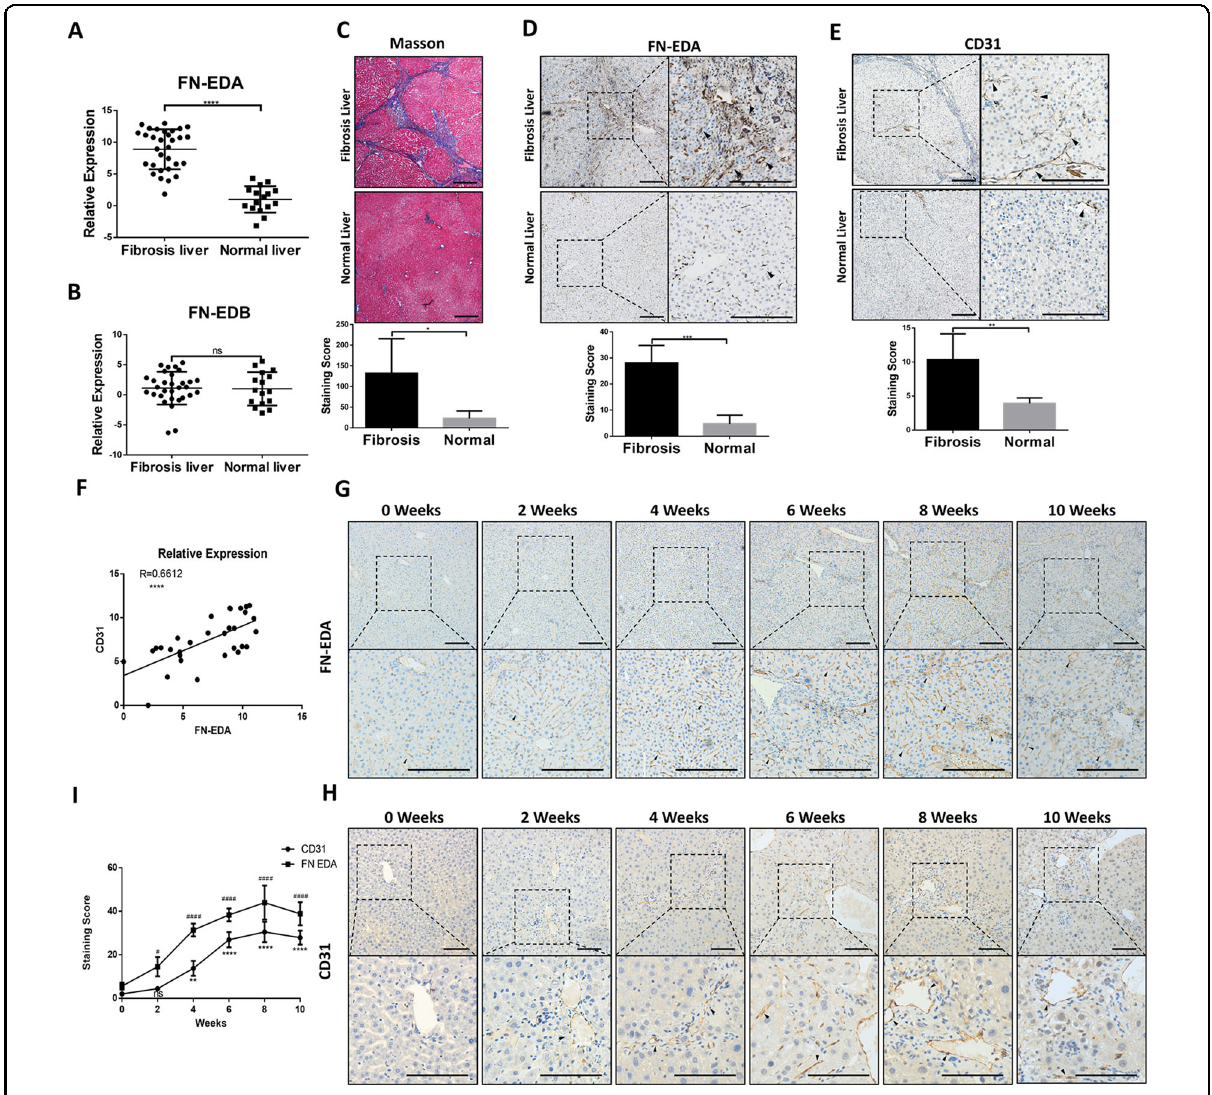
Fig. 1 Expression of FN-EDA is associated with CD31 in hepatic fi brosis. A , B qRT-PCR analysis of FN-EDA and FN-EDB mRNA levels between liver tissue of CHD patients ( n = 30) and healthy control ( n = 15). (GAPDH was used as an internal control. Data are shown as the mean ± SEM. FN-EDA: **** P < 0.0001; FN-EDB: P: ns) C Masson staining in human fi brosis hepatic tissues ( n = 5) and normal tissues ( n = 5). (quanti fi cation relative area of Masson staining. Data are shown as mean ± SEM. * P = 0.0217. Scale bar = 200 μ m. D Immunohistochemical staining of FN-EDA in human fi brosis hepatic tissues ( n = 5) and normal tissues ( n = 5). (Data are shown as mean ± SEM. *** P = 0.0001. Scale bar = 200 μ m). E Immunohistochemical staining of CD31 in human fi brosis hepatic tissues ( n = 5) and normal tissues ( n = 5). (Data are shown as mean ± SEM. ** P = 0.0060. Scale bar = 200 μ m). F qRT-PCR analysis of correlation between FN-EDA and CD31 in human fi brosis hepatic tissues ( n = 30). ( R = 0.6612 **** P < 0.0001) G , H FN- EDA and CD31 staining in livers of CCl4-treated mice biweekly until tenth weeks ( n = 18) (Scale bar = 200 μ m; arrows: staining) I Analysis of FN-EDA and CD31 expression in IHC ( n =